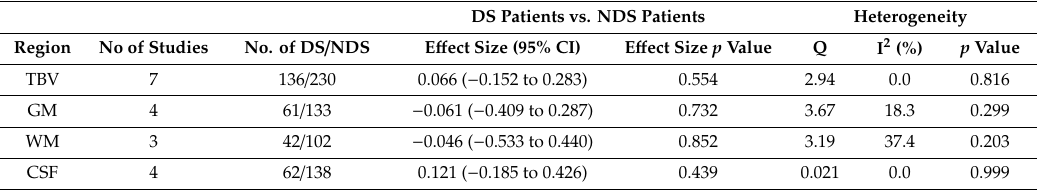
Table 3. Meta-analysis of continuous data comparing patients with DS vs.